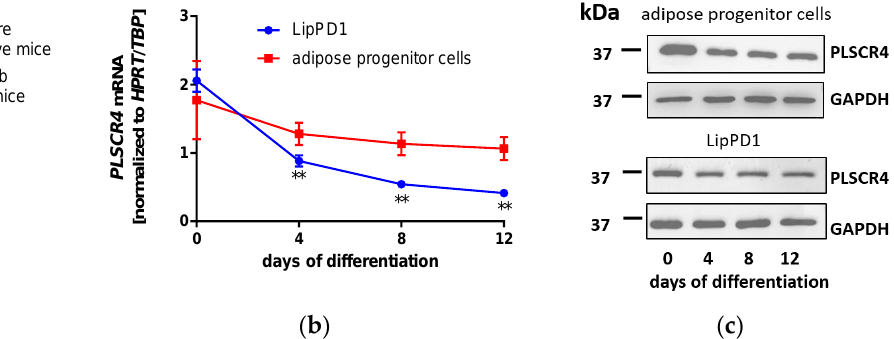
Figure 3. PLSCR4 expression in different models of lipid accumulation. ( a ) Plscr4 expression in lipoma tissue from lipoma Pten / Retinoblastoma (Rb) double knockout (DKO) mice in comparison with epididymal WAT (epiWAT cre neg) and inguinal WAT (ingWAT cre neg) from Cre negative control mice: Plscr4 expression was diminished by 67.7% ± 15.4% in lipoma Pten / Rb DKO compared with epiWAT (normalized to Hprt and Tbp ; n = 7; p = 0.0019) and by 58.4% ± 23.5% (normalized to Hprt and Tbp ; n = 7; p = 0.0318) compared with ingWAT. ( b ) PLSCR4 expression during adipogenesis in human PTEN-deficient lipoma cells (LipPD1) and adipocyte progenitor cells (APCs) at mRNA level: PLSCR4 was significantly downregulated in LipPD1 cells after 4, 8, and 12 days (normalized to HPRT and TBP ; n = 4; p < 0.01). ( c ) Downregulation of PLSCR4 in APCs and LipPD1 cells during adipogenesis was observed at protein level (one representative experiment out of two is shown). p -values for panels ( a , b ) were determined via one-way ANOVA followed by post hoc Dunnett ’ s multiple comparison test (* p < 0.05, ** p < 0.01). PLSCR4, phospholipid scramblase 4; HPRT, hypoxanthine phosphoribosyl transferase; TBP, TATA-box binding protein; LipPD1, lipoma cell strain of a patient with PTEN hamartoma tumor syndrome (PHTS) carrying a heterozygous germline microdeletion in the PTEN gene.